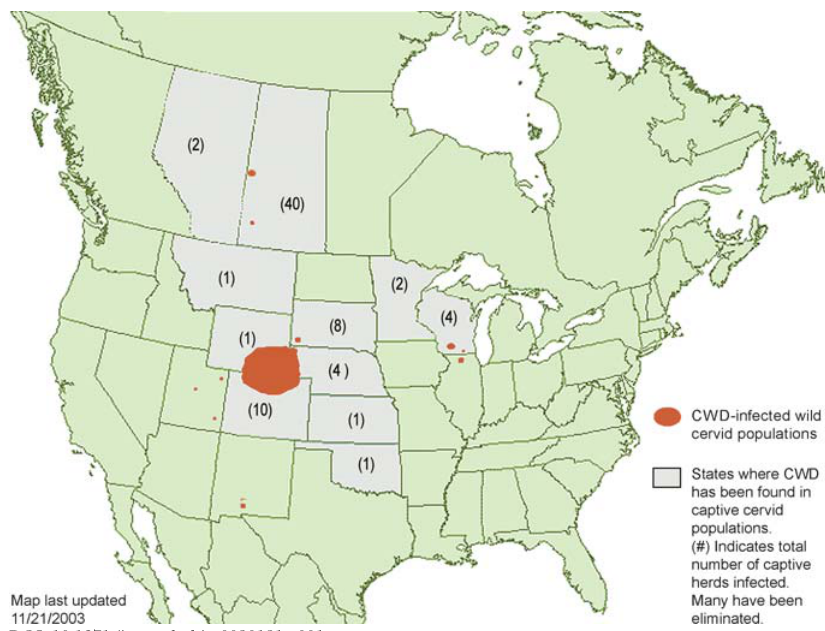
Figure 1. CWD in North America CWD has been detected in both free-ranging and captive animals in Wyoming, Colorado, South Dakota, Wisconsin, and Saskatchewan; only in captive herds in Montana, Nebraska, Kansas, Oklahoma, Minnesota, and Alberta; and only in wild animals in New Mexico, Utah, and Illinois. (Figure courtesy of Gary Wolfe and the CWD